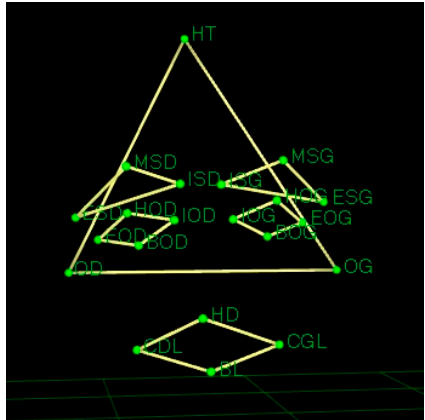
Figure 4. Schematic overview of the finest projection plan.